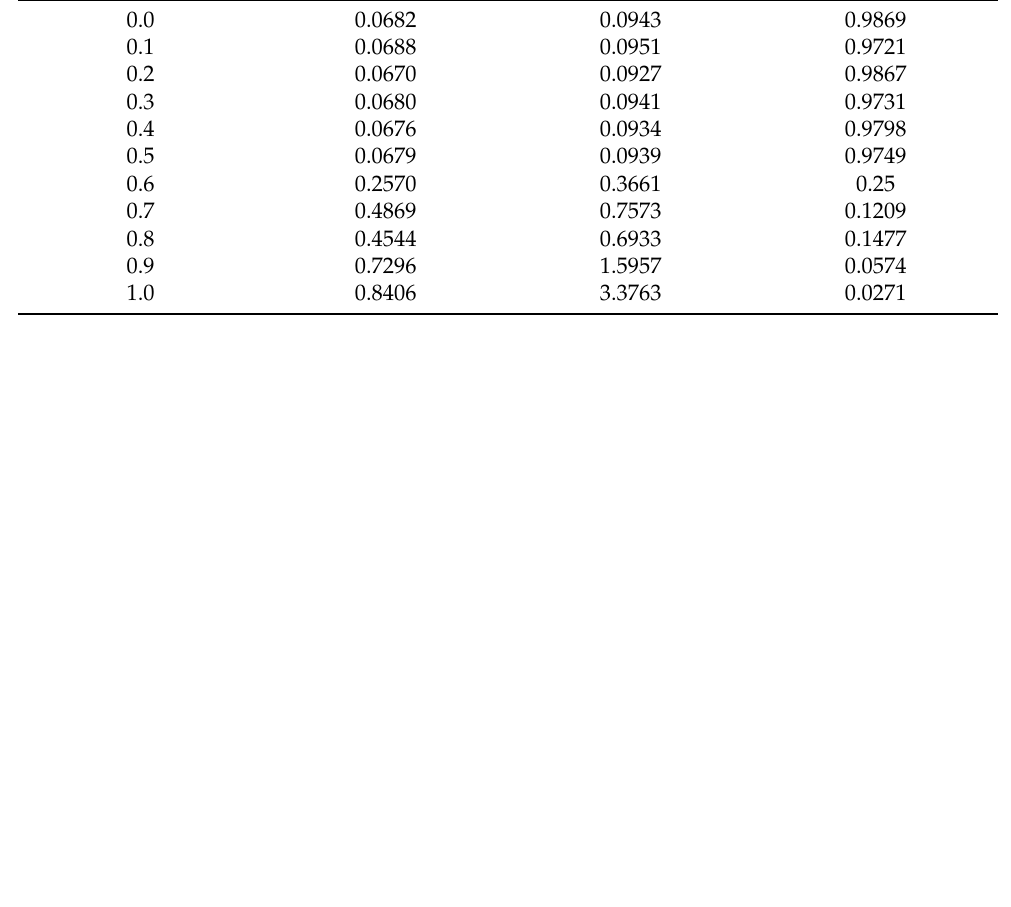
Table 1. Optimization results by the method using the genetic algorithm. K 1 K